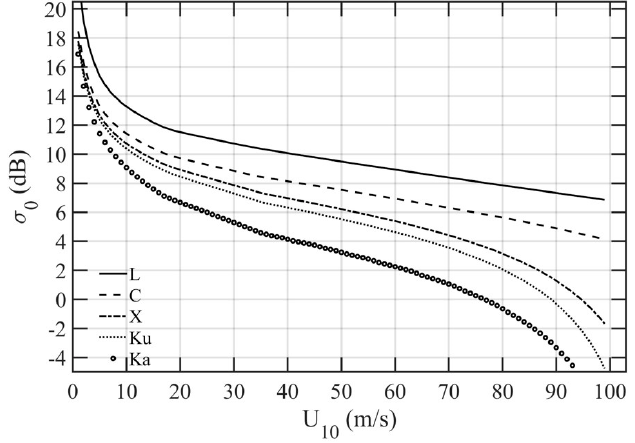
Figure 10. Specular NRCS (normal incidence) dependence on wind speed for L (1.575 GHz), C (6 GHz), X (10 GHz), Ku (14 GHz), and Ka (35.75 GHz) bands. All computed with the H18 LPMSS integrated to k r /3.